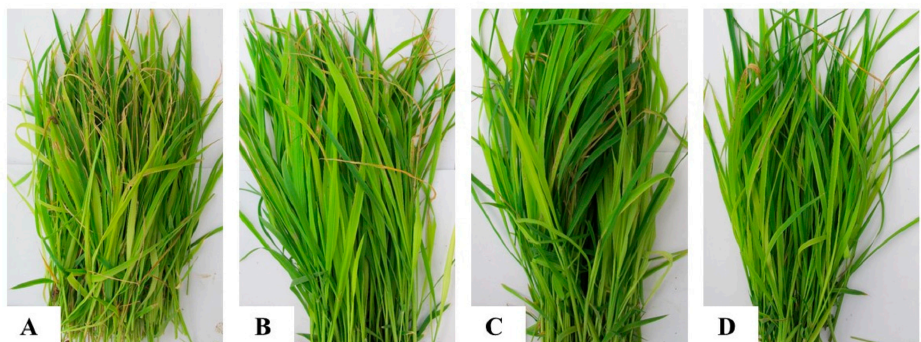
Figure 1. Rice seedlings either untreated ( A ) or treated with probenazole at 75.00 g · m − 2 ( B ), after the treatment.